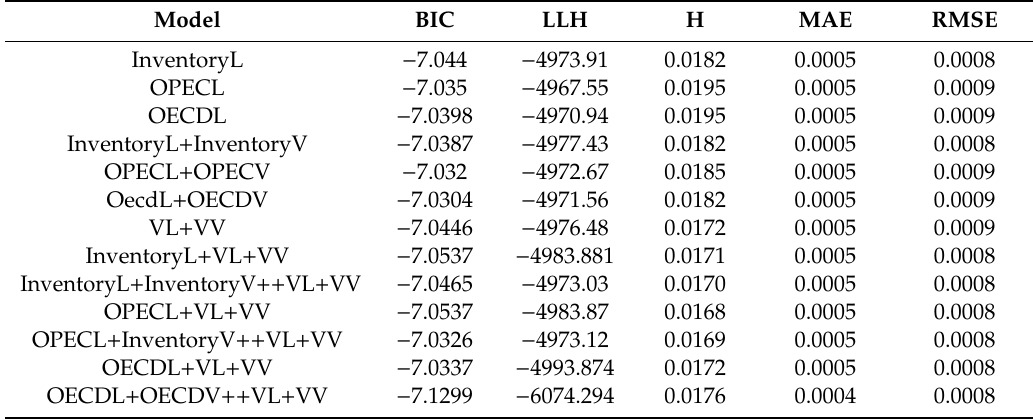
Table 12. Comparison between the associative e ff ect model of high-frequency and low-frequency factors and single-factor e ff ect model.